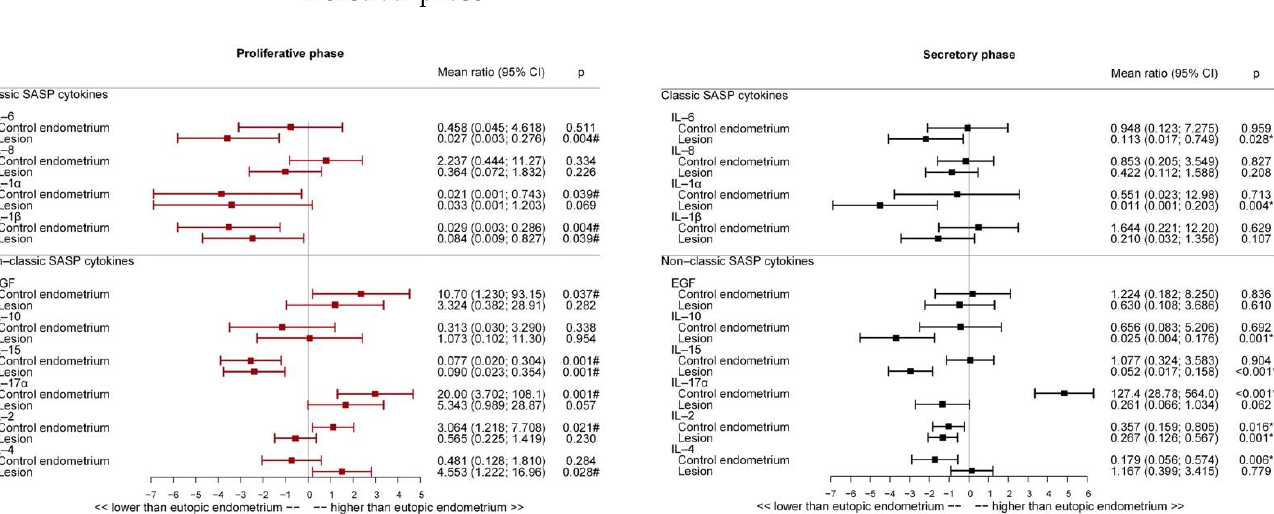
were acquired at 20 × magnification. ( b ) Representative images of p16 Ink4a and ( c ) lamin b1 co- stained with e-cadherin in deep endometriosis lesion tissues. p16 Ink4a and anti-lamin b1 are shown in red, e-cadherin in green, and the blue color (DAPI—4 (cid:48) ,6-diamidino-2-phenylindole) marks the cell nuclei. The red arrow shows cells that are only stained for p16 Ink4a or lamin b1, and the yellow star shows epithelial cells stained for both p16 Ink4a and lamin b1. Pictures were acquired at 20 × and 100 × magnifications.